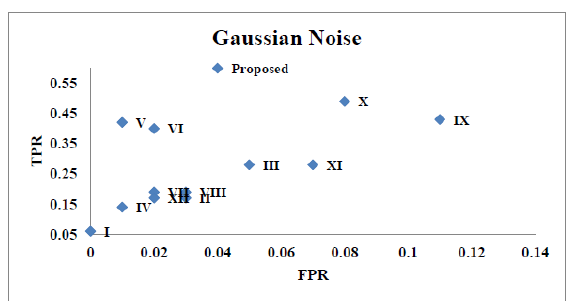
Figure 10. TPR vs. FPR: Gamma Correction.